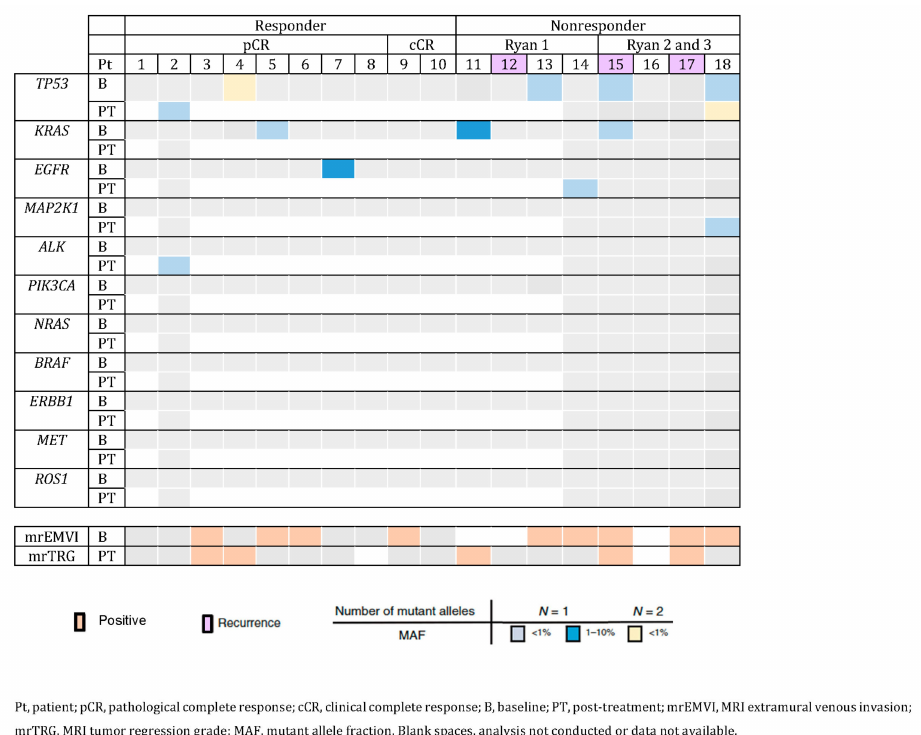
Figure 2. Genomic landscape of the mutations detected in plasma and imaging